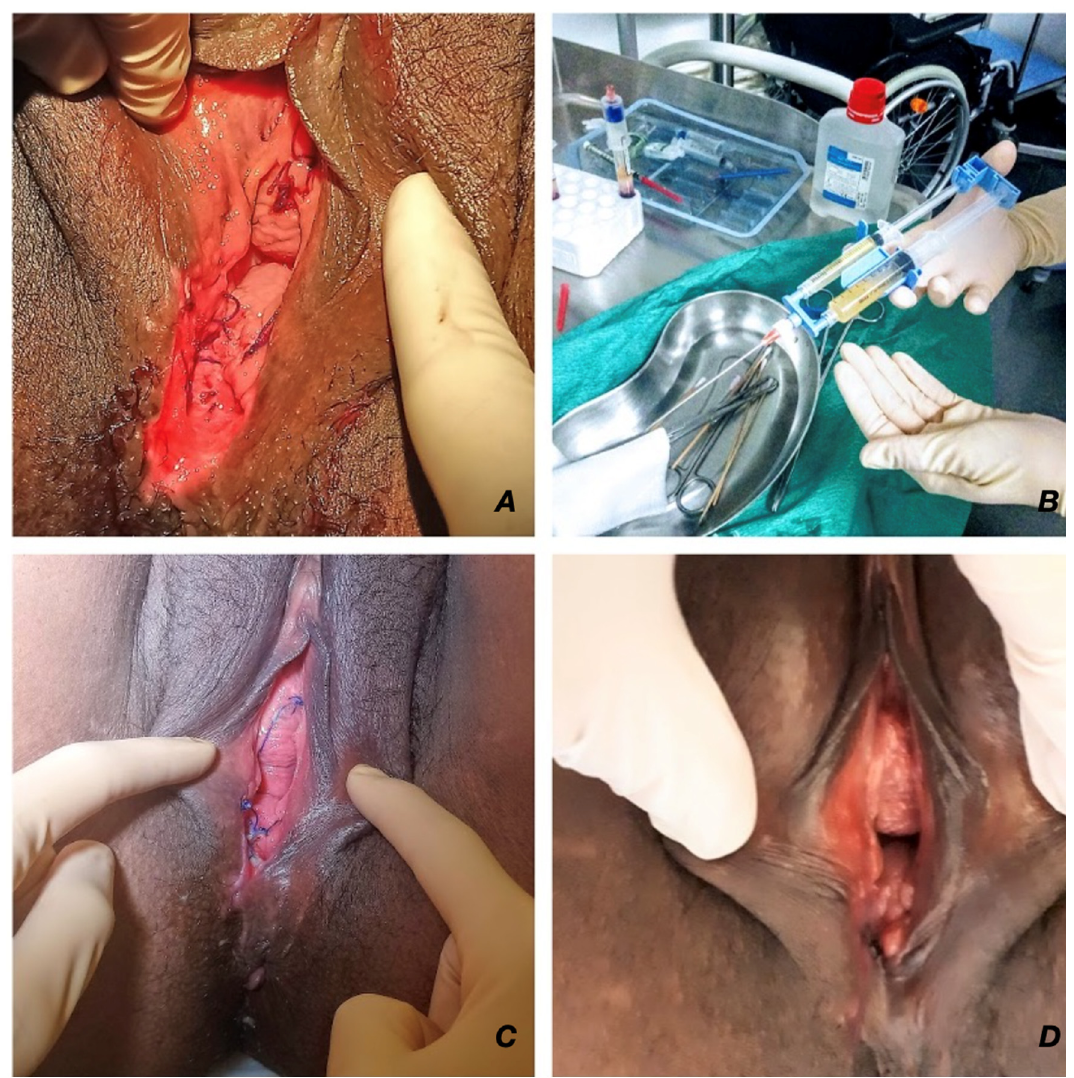
Figure 1. ( A ) Perineal status on the day of admission: a non-infected breakdown of a 2 cm deep and 3 cm long dehiscence, including the muscle layer. ( B ) Autologous fibrin glue preparation obtained from RegenKit-Surgery (Regen Lab ® SA, Switzerland). ( C ) Day 7 following the A-PRP administration. ( D ) Day 22 following the A-PRP administration.